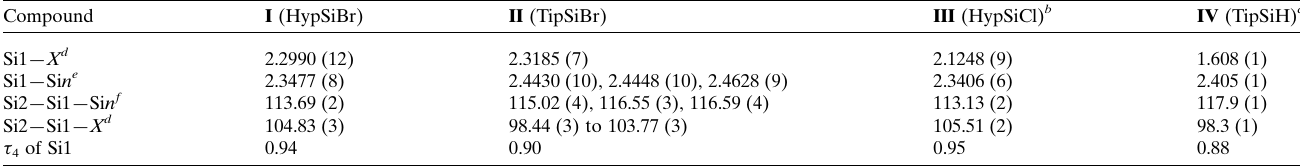
Table 1 Selected bond lengths (A˚ ), bond angles ( (cid:3) ) and the fourfold coordination descriptor, (cid:2) 4 , a for compounds I (HypSiBr), II (TipSiBr), III (HypSiCl) and IV (TipSiH).